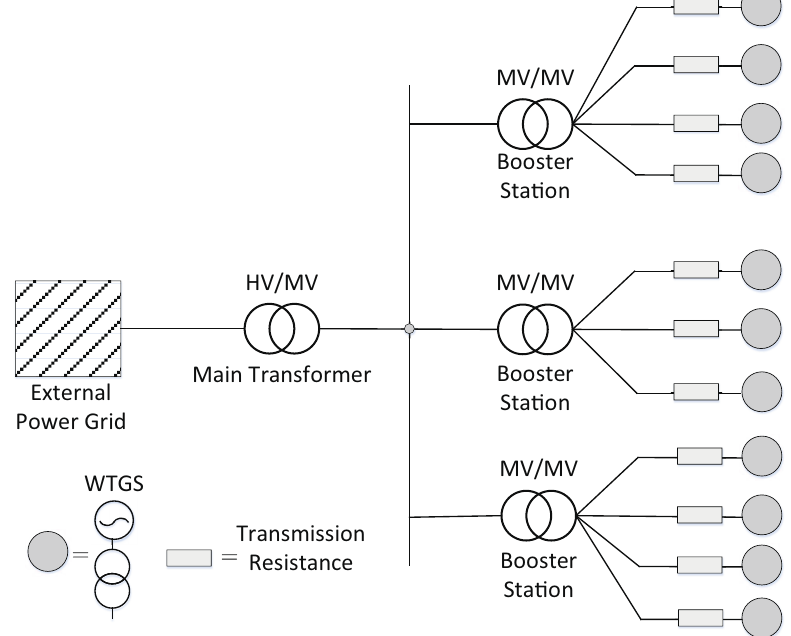
Figure 1. Wind farm topology. High voltage (HV), medium voltage (MV), and wind turbine generator system